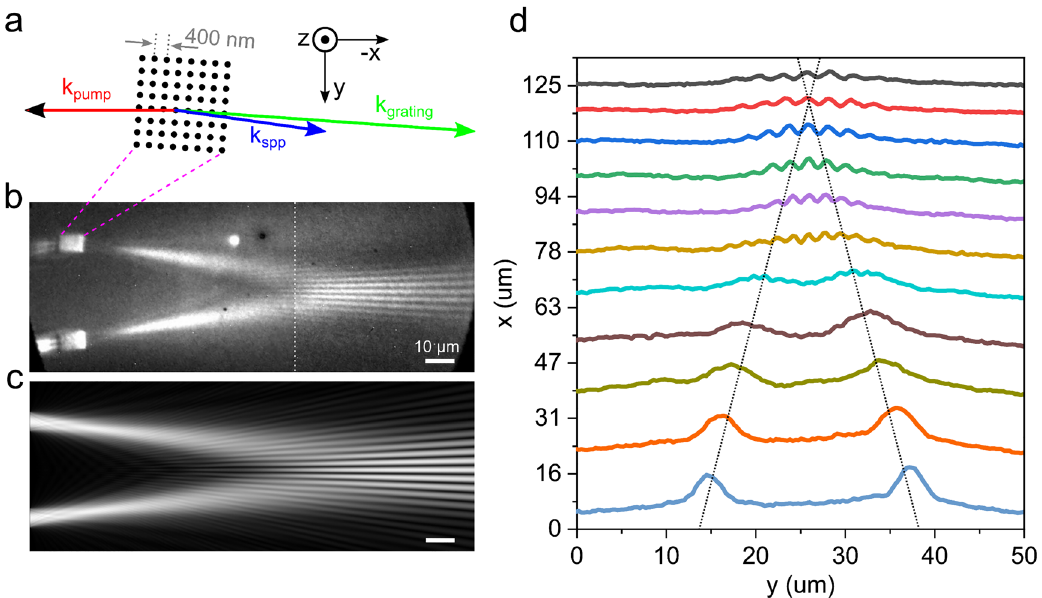
Figure 2: (a) Wave vector matching diagram for counter-propagating surface plasmon polariton (SPP) excitation at an angle superposed on a schematic of the 2D photonic Bragg grating (2PG). (b) Time-integrated 2-photon photoemission (2PPE) image of SPP surface fields displaying spatial interference. Note, the image contrast was enhanced on the right-hand side of the dashed line. The periodic intensity modulation evolves as the SPPs propagate, as evidenced by the change in fringe spacing. (c) The profile may be recovered by explicitly describing the diverging plasmonic fields and their time evolution through finite-difference time-domain (FDTD) simulations. (d) Profiles extracted from the image measured in b. The trajectories of the nascent SPP are indicated by the dashed lines.